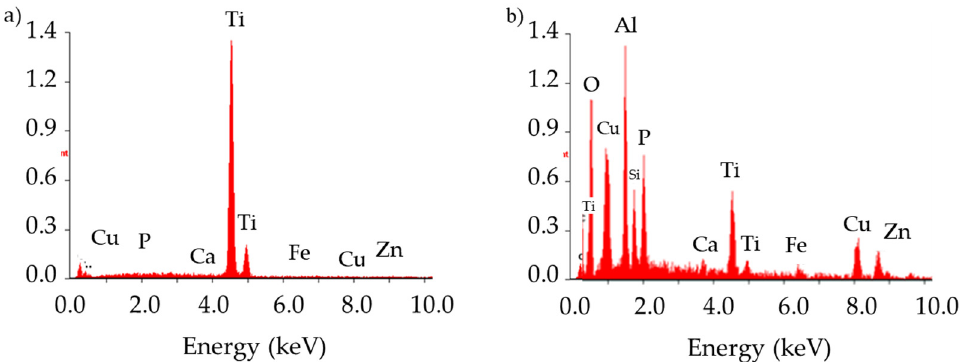
Figure 4. Analysis of the chemical composition of the implant ( a ) and the inclusion ( b ).